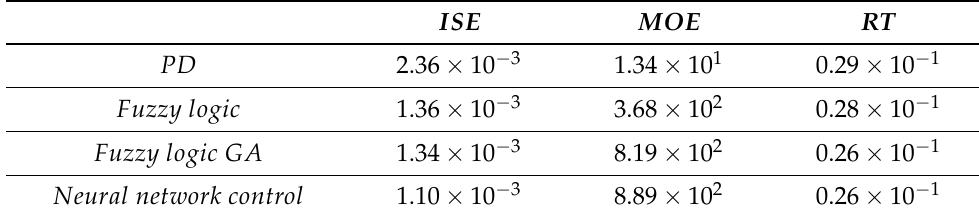
Table 3. The results of the performance